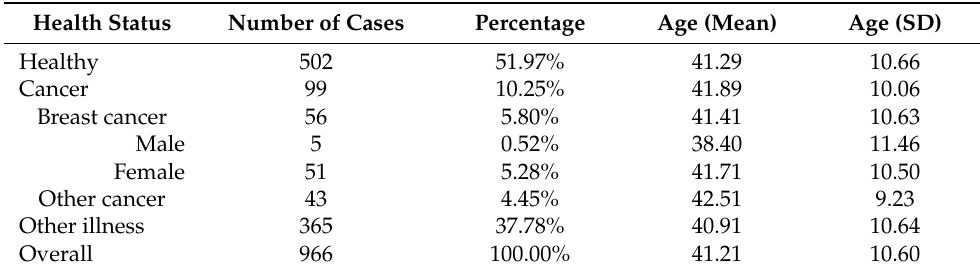
Table 1. General descriptive analysis (N = 966).